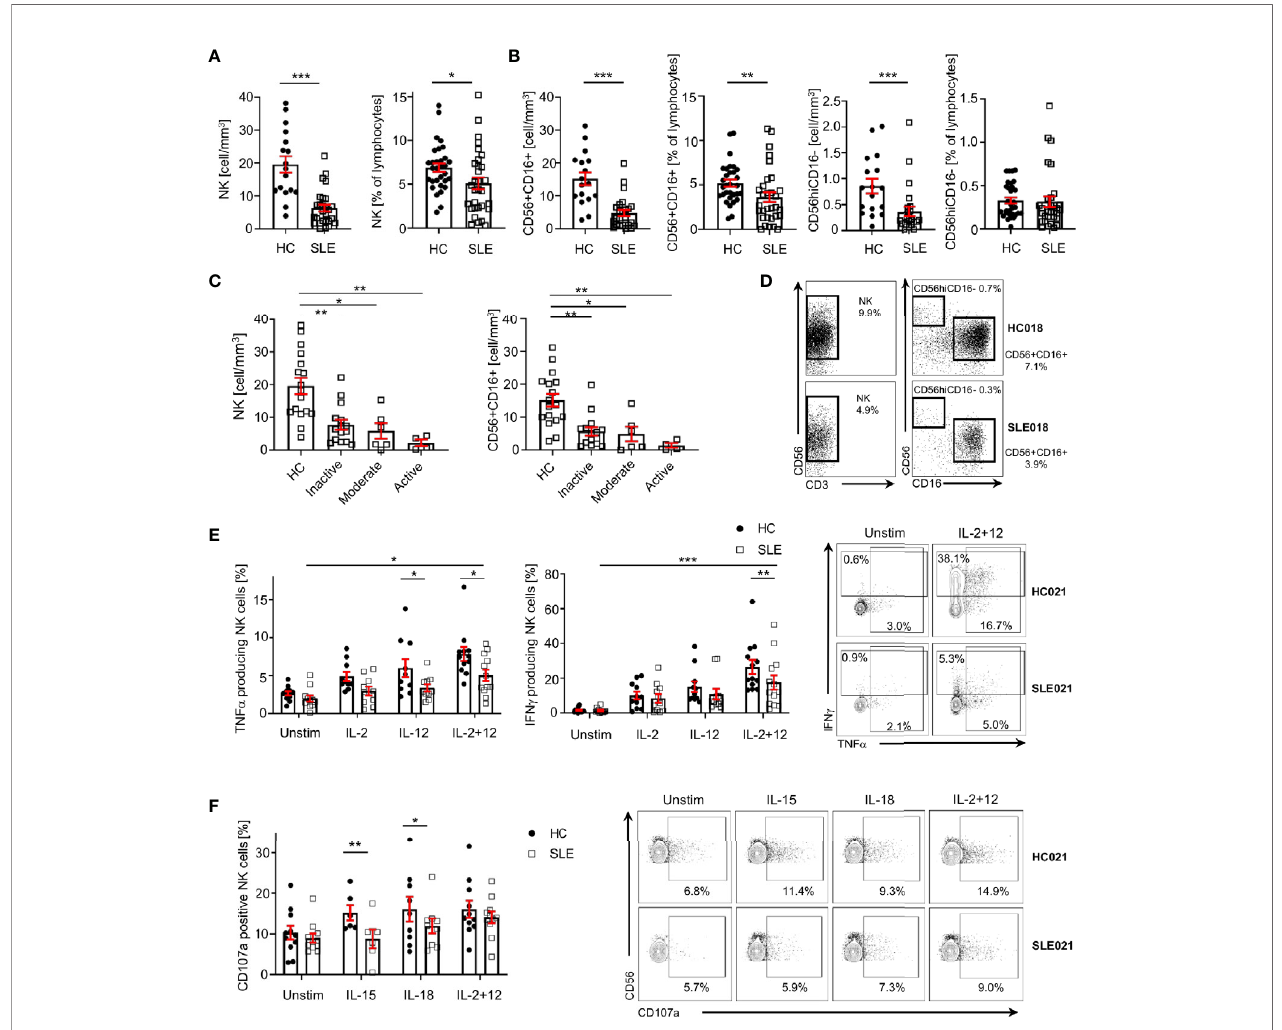
FIGURE 1 | NK cells are decreased and dysfunctional in patients with SLE. (A) Total NK cells and (B) CD56+CD16+ and CD56hiCD16- NK subpopulations in SLE patients and HC are shown as absolute number (HC=17, SLE=27; Mann-Whitney Test) and percentage of total lymphocytes (HC=31, SLE=31; Mann-Whitney Test). (C) Total NK cells and CD56+CD16+ absolute number according to SLE disease activity (HC=17, Inactive=15, Moderate=6, Active=4; Kruskal-Wallis Test with Dunn ’ s multiple comparison test). (D) Representative dot-plot of NK cells (left) and subpopulations (right) staining gated on live CD45+CD14-CD7+CD20-CD19- cells. The percentages of NK, CD56+CD16+ and CD56hiCD16- refer to % of total lymphocyte count. (E) Cumulative results and representative dot-plot showing NK cell cytokines production in SLE and HC after overnight stimulation (IFN g HC=12, SLE=12; TNF a HC=13, SLE=13; mixed-effects analysis and two-way ANOVA with Sidak ’ s multiple comparison test). (F) Cumulative results and dot-plot showing NK cell degranulation (CD107a+ cells) after overnight stimulation in SLE and HC (HC=11, SLE=11; two-way ANOVA and Sidak ’ s multiple comparison test). Data represent mean ± SEM (*P < 0.05, **P < 0.01, ***P < 0.001). HC, healthy